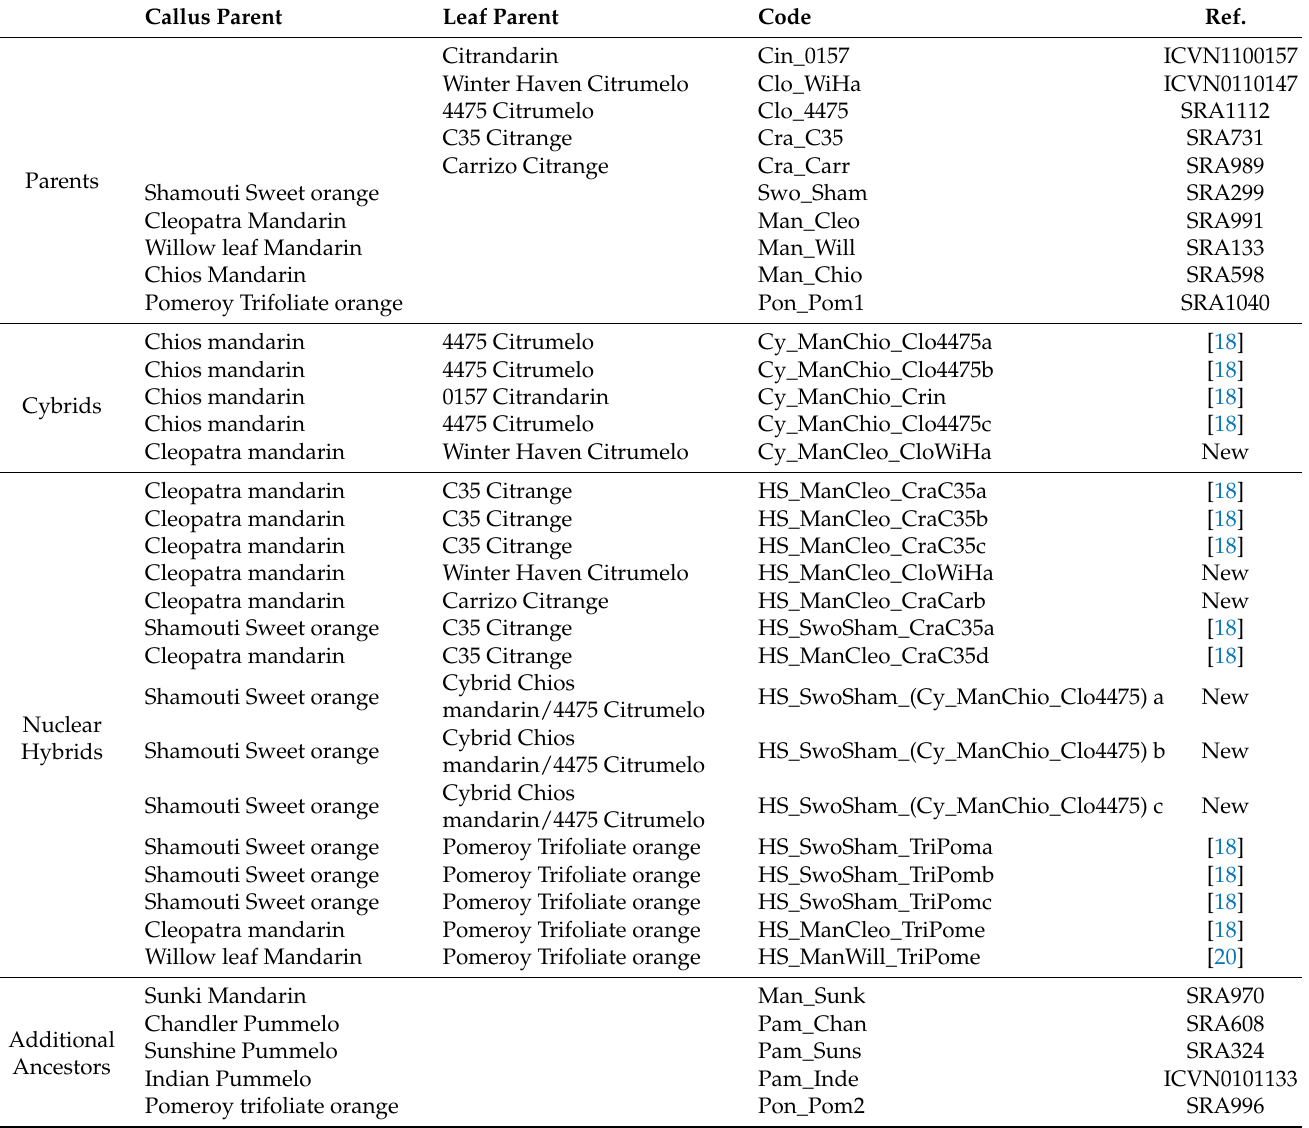
Table 1. Cybrids, nuclear somatic hybrids, parents, and ancestral taxa representatives analyzed by GBS.